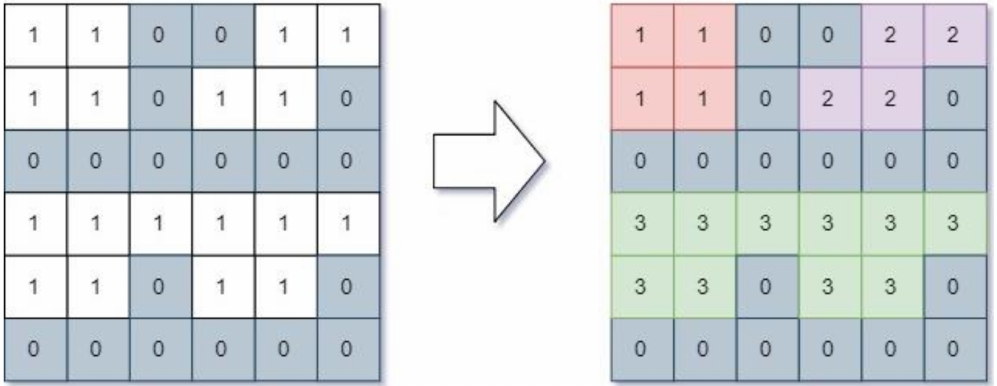
Figure 4. The schematic diagram of connected-component labeling. Mark the connected white pixels (value equal to 1) with the same color and label numbers.